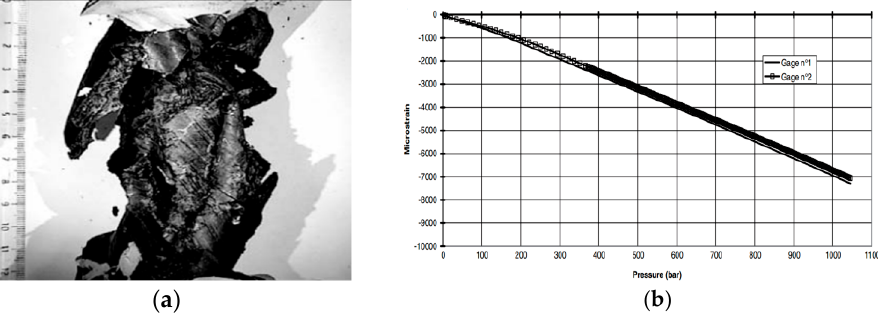
Figure 8. Experimental results of thick carbon fiber reinforced epoxy composite tube under hydro- static pressure [72]. ( a ) cylinders after implosion ( b ) axial and hoop strain response